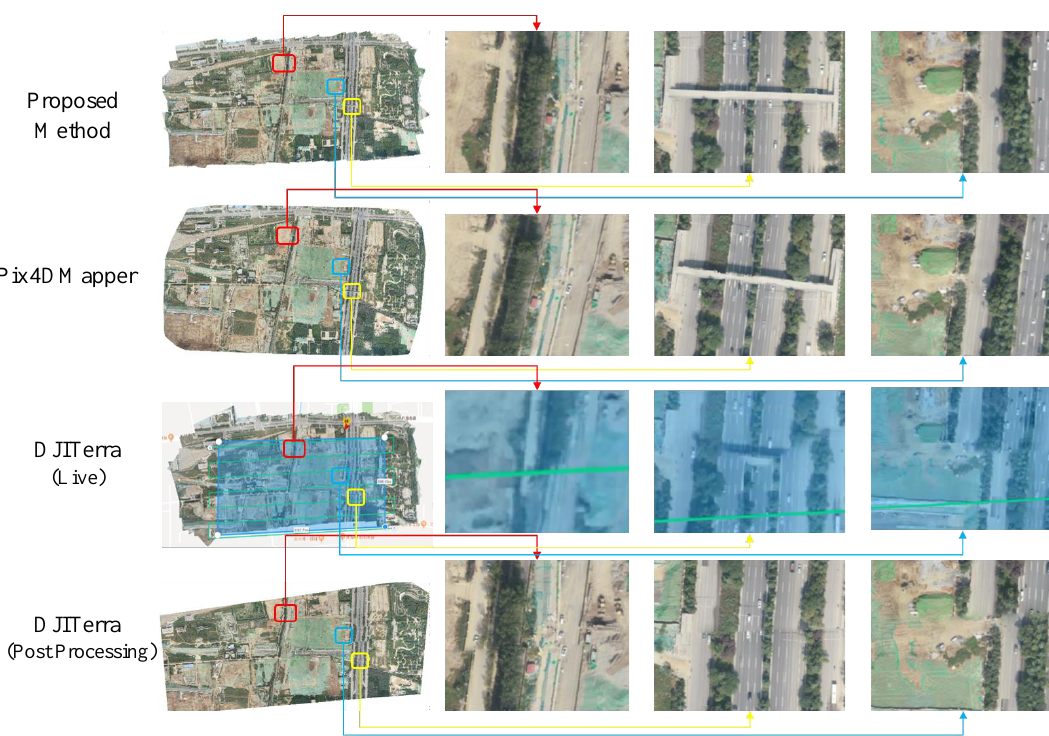
Figure 5. Stitching result comparison between the proposed method and state-of-the-art commercial software. DJITerra will launch a postprocessing step to refine the mosaic. Thus, we illustrate the result before and after postprocessing. DJITerra performs unsatisfactorily in this flight with evident mismatches in live map or postprocessing results due to the low flight overlap and random pitch. Our system is able to handle these challenges and output high-quality live orthophoto, which even looks better than Pix4DMapper, where the bridge and roads looks